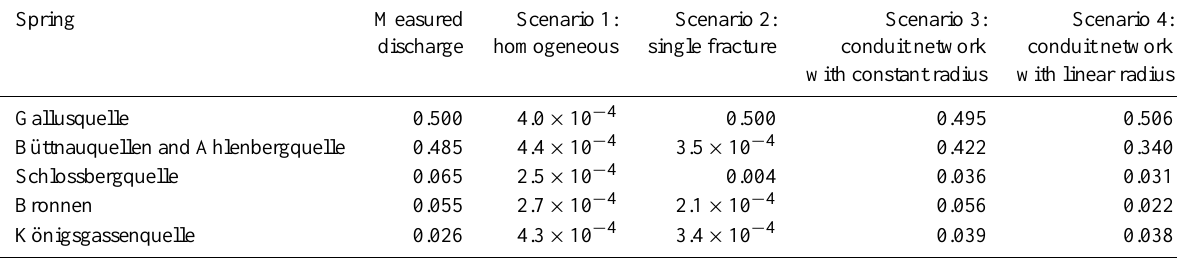
Table 2. Simulated spring discharges (m 3 s − 1 ) for all scenarios.